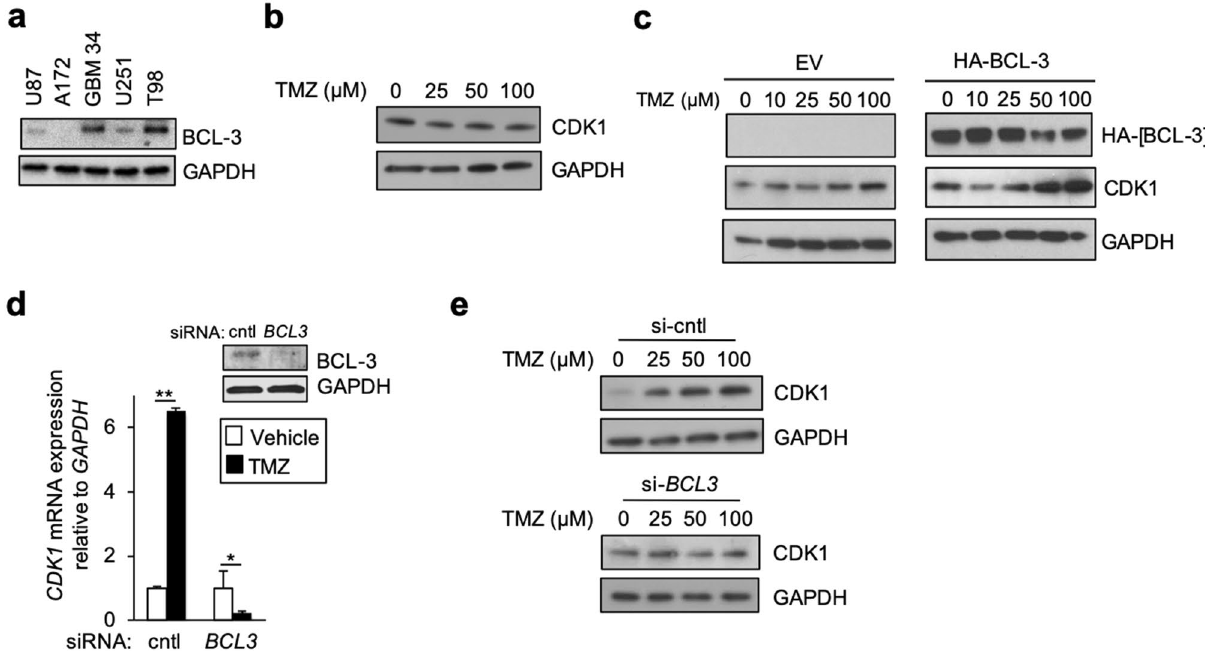
Figure 2. BCL-3 is required for induction of CDK1 by TMZ. ( a – c ) IB with anti-CDK1, anti-BCL-3, anti-HA, or anti-GAPDH. ( a ) IB using lysate from the indicated cell line. ( b ) IB in A172 cells following treatment with TMZ (24 h). ( c ) A172 cells expressing either HA-BCL-3 or empty vector (EV) following treatment with the indicated concentration of TMZ (24 h). ( d ) qPCR analysis of mean CDK1 mRNA in U87 cells transfected with si-control (cntl) or si– BCL3 treated with TMZ (100 μM, 24 h). Data show mean expression relative to GAPDH , ± SD of triplicate samples. Inset: IB with anti-BCL-3. ( e ) IB with anti-CDK1 or anti-GAPDH in U87 cells transfected with si-control or si- BCL3 following treatment with TMZ for 24 h at indicated concentration. IB data representative of duplicate experiments. * P < 0.05, ** P <